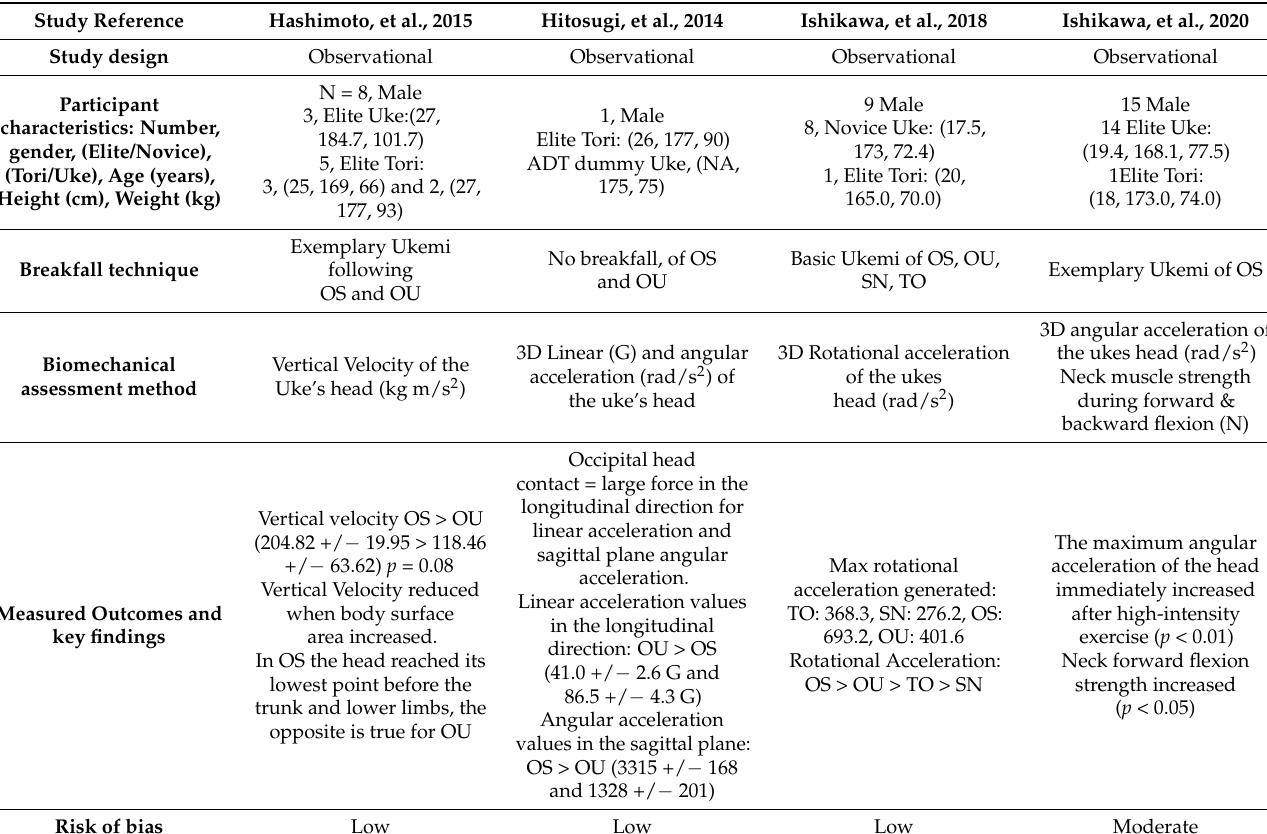
Table 2. Study characteristics and outcomes.